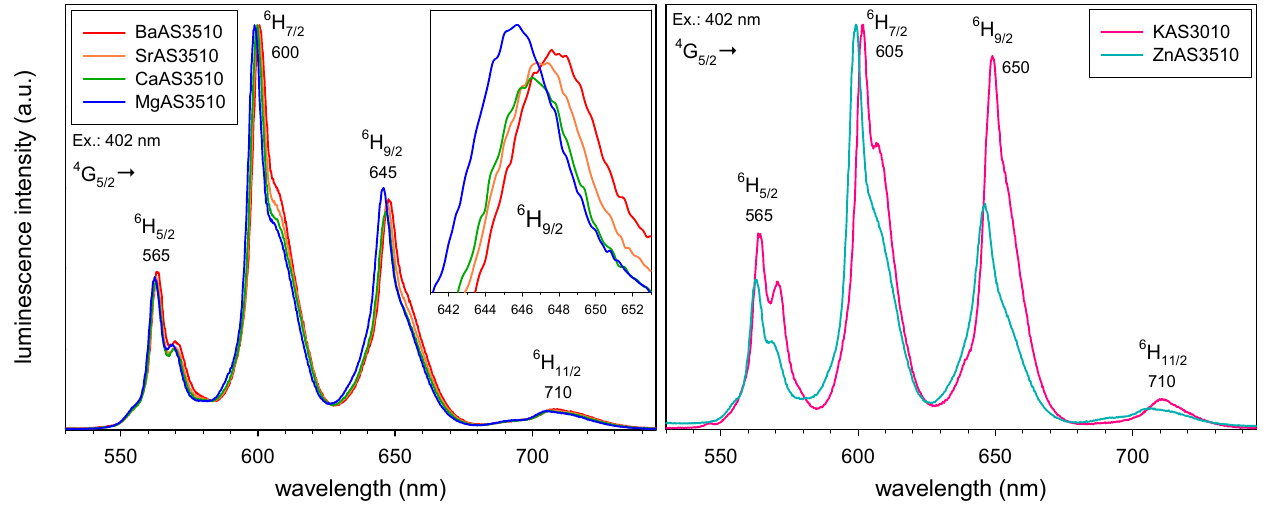
Figure 1. Sm 3+ emission spectra of different alkaline earth aluminosilicate glasses ( left ), and of a potassium and a zinc aluminosilicate glass ( right ) excited at around 402 nm. The spectra are normalized to their most intense peak at around 600 nm. The peak intensity of the peak at 645 nm shows clear differences in dependence of the host glass (magnified in the inset left).